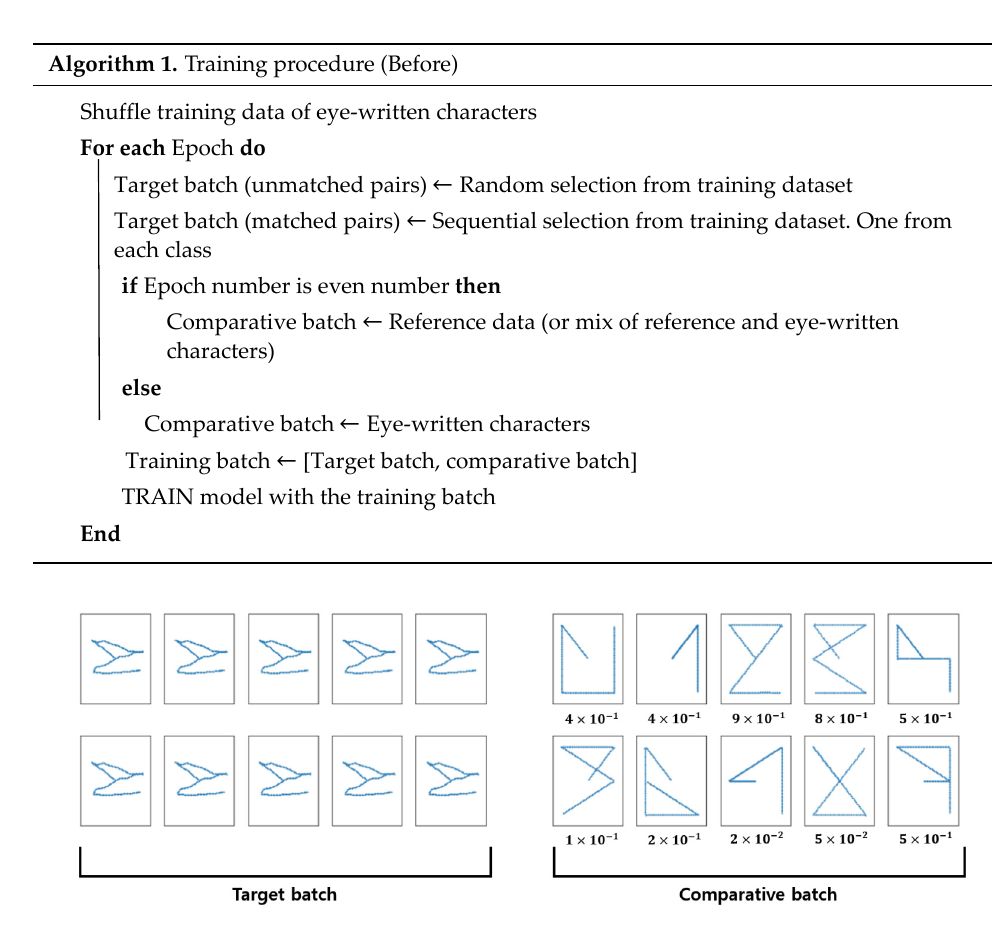
Table 1. Train and test data separation with different ratios.